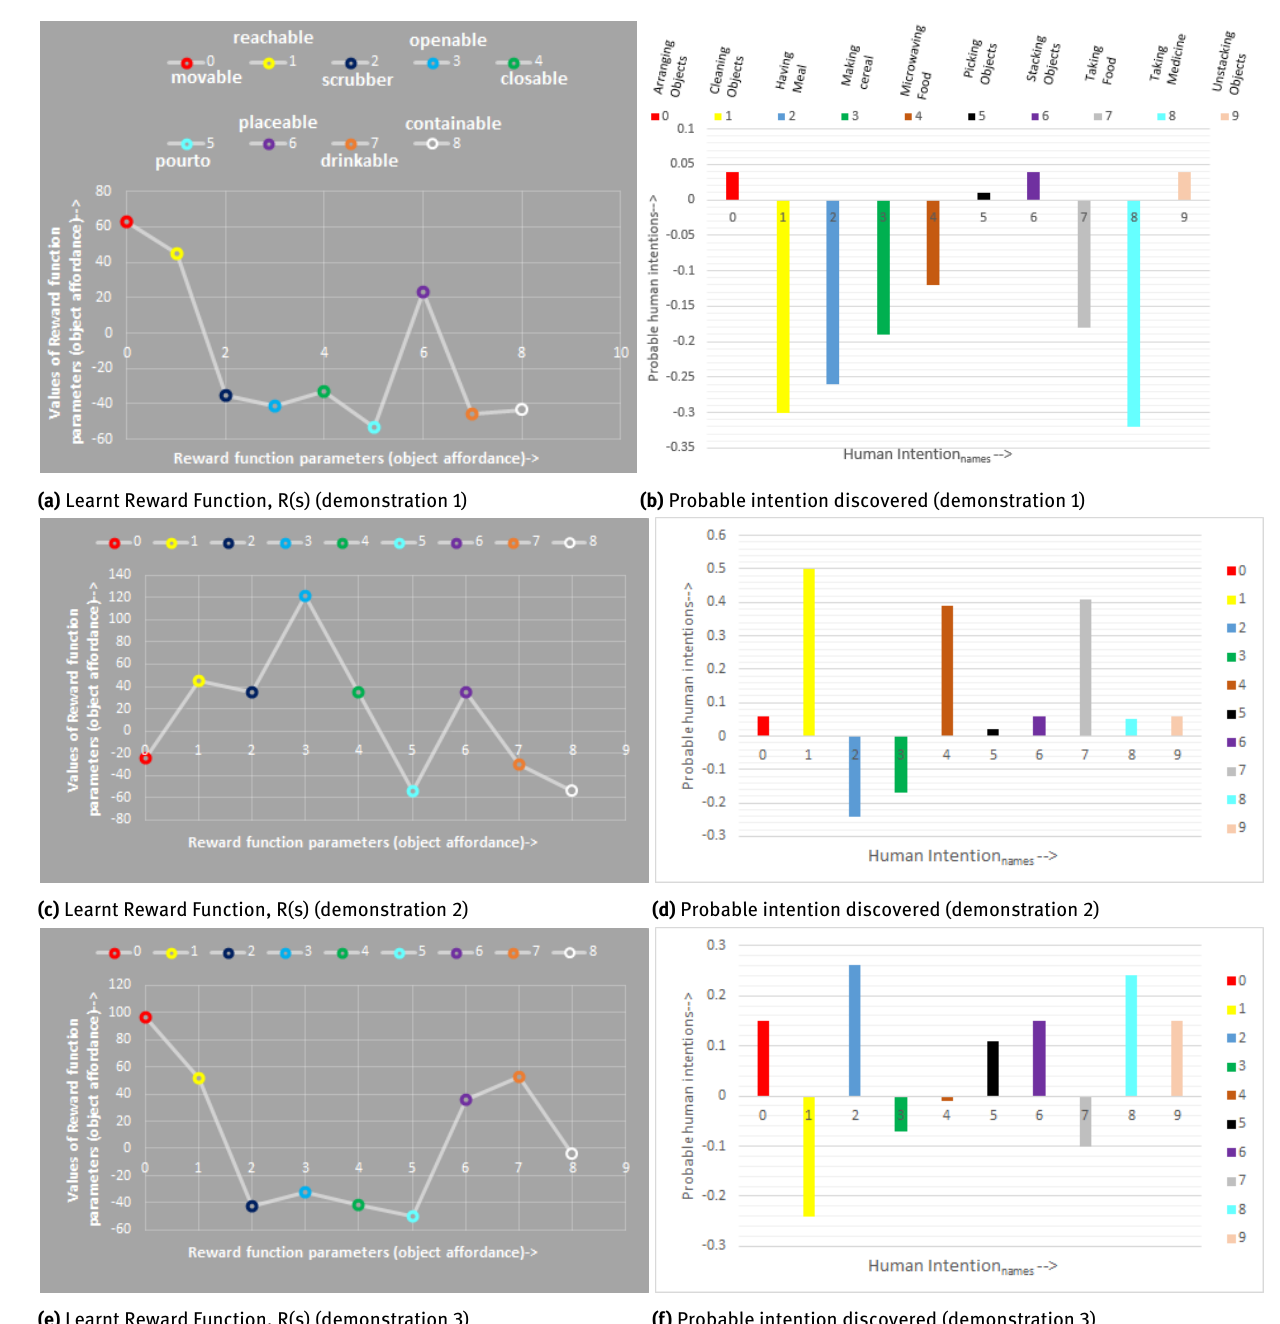
Figure 4: This figure consists of three pair of graphs originated from three categories of demonstrations of CAD-120 dataset. Each pair cor- responds to a particular category of demonstration. The first graph (dark one) of each pair is obtained due to I a and it shows the learnt reward function. The second graph of each such pair is present in the right hand side of this graph (dark one). It is obtained due to Ha . It shows the probable intentions discovered by our approach. Various legends have been used for representing the attribute values of both the graphs of each pair. In Figure 4a and Figure 4b, the meaning of the legends (markers) have been provided in the figure itself. The leg- ends in Figure 4c and Figure 4e carries the same meaning as annotated in Figure 4a. Similarly, the meaning of the legends in Figure 4d and Figure 4f carries the same meaning as annotated in Figure